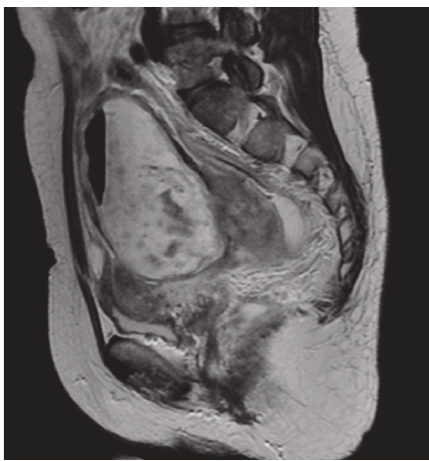
Figure 1: Abdominopelvic magnetic resonance imaging shows a complex mass containing a pocket of air in the pouch of Douglas.